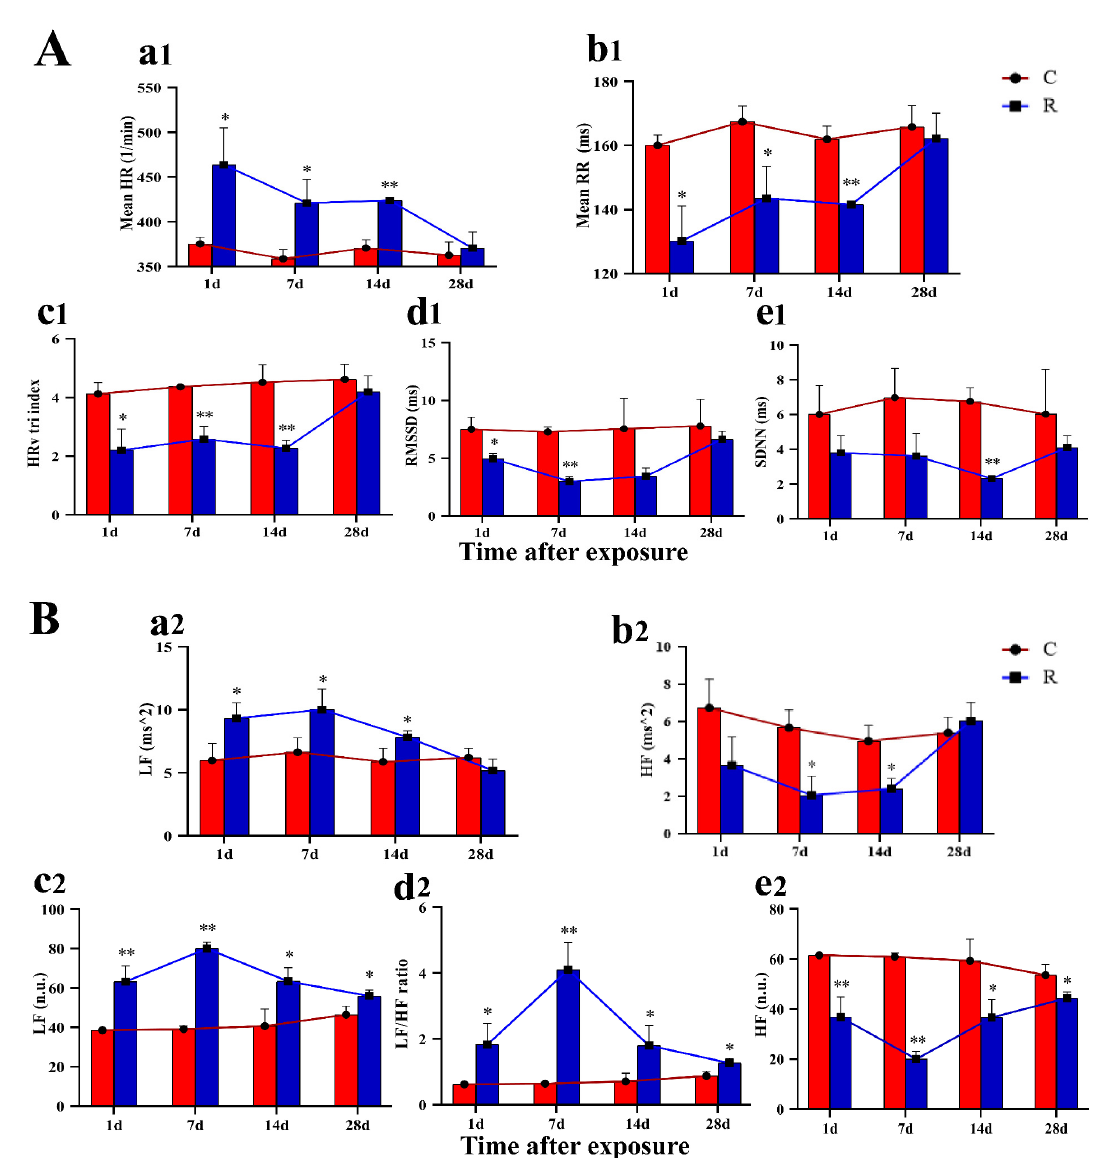
Figure 7. Changes in indicators related to HRV in rats after S-band radiation. ( A ) Time-domain related indicators: ( a1 ) mean HR, ( b1 ) mean RR, ( c1 ) HRV tri-index, ( d1 ) RMSSD, ( e1 ) SDNN; ( B ) frequency-domain related indicators: ( a2 ) LF-ms 2 , ( b2 ) HF-ms 2 , ( c2 ) LF-nu, ( d2 ) LF/HF radio, ( e2 ) LF-nu. Significance signs were classified according to p -value: * p < 0.05 and ** p < 0.01.